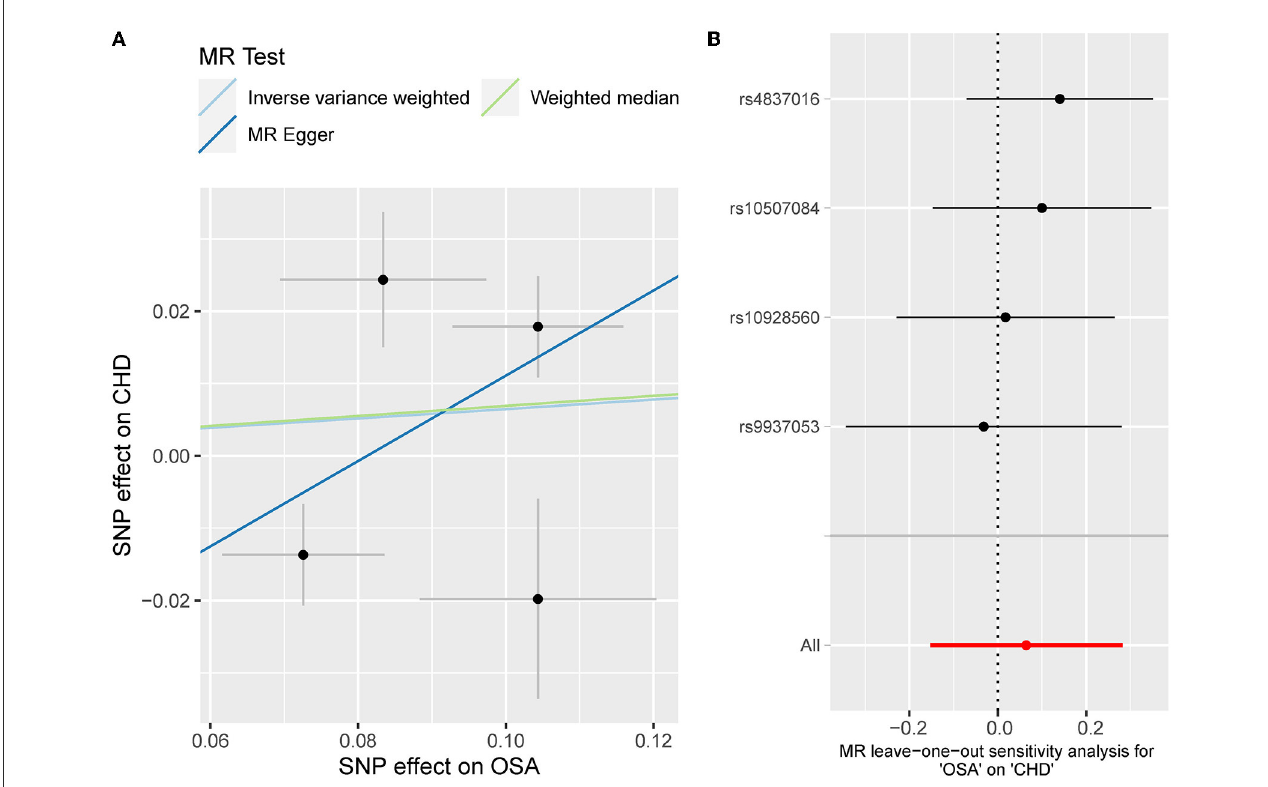
FIGURE5 (A) The scatterplot of OSA-CHD results. Different colors represent different methods and each point is a single nucleotide polymorphism. The horizontal and vertical lines of each point represent the 95% confidence interval of the effect size. (B) The leave-one-out-sensitivity forest plot of OSA-CHD